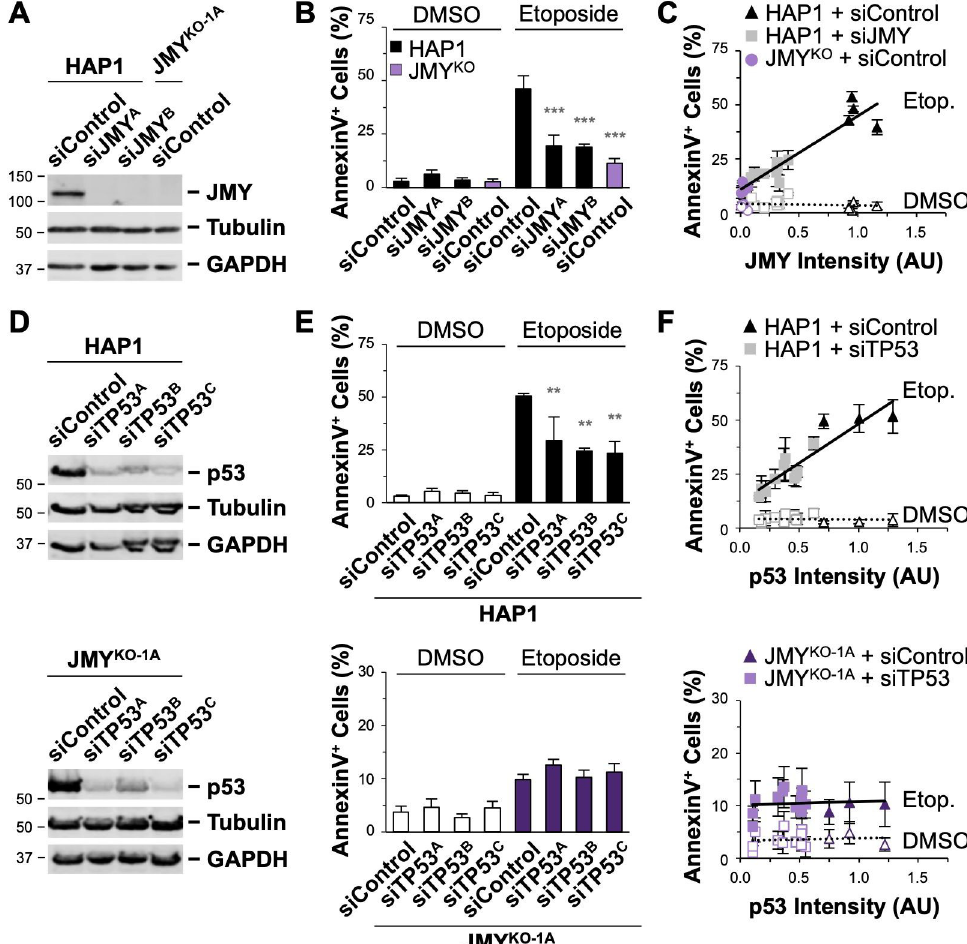
Fig 5. Cells transiently depleted of JMY or p53 have similar reductions in apoptosis. (A) HAP1 cells were treated with control siRNAs or independent siRNAs for the JMY gene, while a JMY KO cell line was treated with control siRNAs before immunoblotting with antibodies to JMY, tubulin, and GAPDH. (B) Cells were treated with DMSO or 5 μ M etoposide for 6h and stained with Alexa488-AnnV, PI, and Hoechst. The % of AnnV-positive cells was calculated, and each bar represents the mean ± SD from 4 experiments (n = 4,508–7,626 cells per bar). (C) JMY band intensities on immunoblots were normalized to tubulin intensities and plotted against the % of AnnV-positive cells. Each point represents the mean ± SD from 3 fields-of-view in a given experiment (n = 564–2,587 cells per point). The slope in the linear trendline regression equation for etoposide-treated samples (Y = 34.56X + 10.52) was significantly non-zero (p < 0.001, R 2 = 0.86). (D) HAP1 and JMY KO-1A cells were treated with control siRNAs or independent siRNAs for the TP53 gene before immunoblotting with antibodies to p53, tubulin, and GAPDH. (E) Cells were treated and stained as in panel (B). The % of AnnV-positive cells was calculated, and each bar represents the mean ± SD from 3 experiments (n = 2,194–5,237 cells per bar). (F) p53 band intensities on immunoblots were normalized to tubulin intensities and plotted against the % of AnnV- positive cells. Each point represents the mean ± SD from 3 fields-of-view in a given experiment (n = 273–2,217 cells per point). The slope in the linear trendline regression equation for HAP1 etoposide-treated samples (Y = 33.47X + 12.48) was significantly non-zero (p < 0.001, R 2 = 0.74). Significance stars refer to comparisons to the HAP1 siControl samples. �� p < 0.01; ��� p < 0.001 (ANOVA, Tukey post-hoc